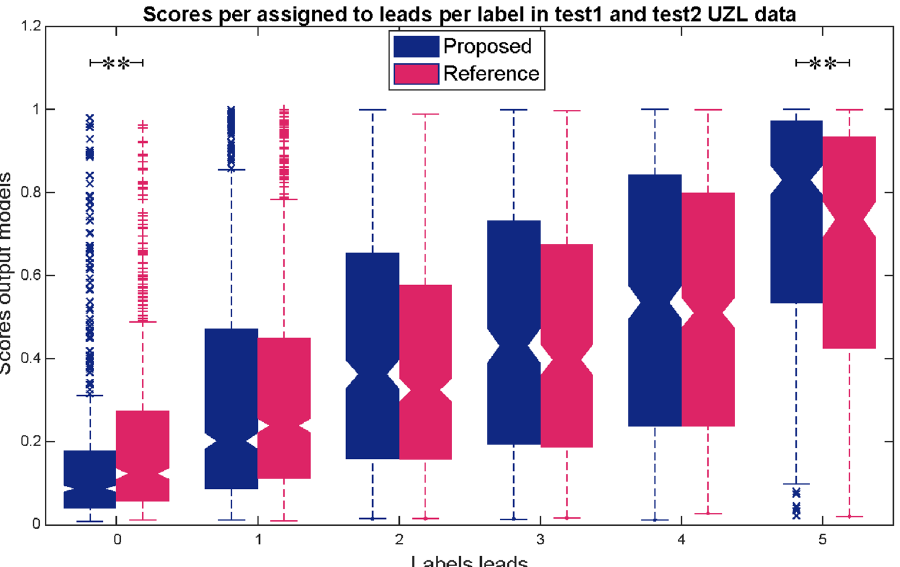
Figure 7. Relation between the output scores of the proposed and reference approaches (in blue and pink) with the labels of test2 UZL signals, ranging from 0 to 5. Friedman test was applied to compare the results of both approaches, obtaining p-values below 0.005. These statistically significant differences are described by the sign ** in groups 0 and 5.